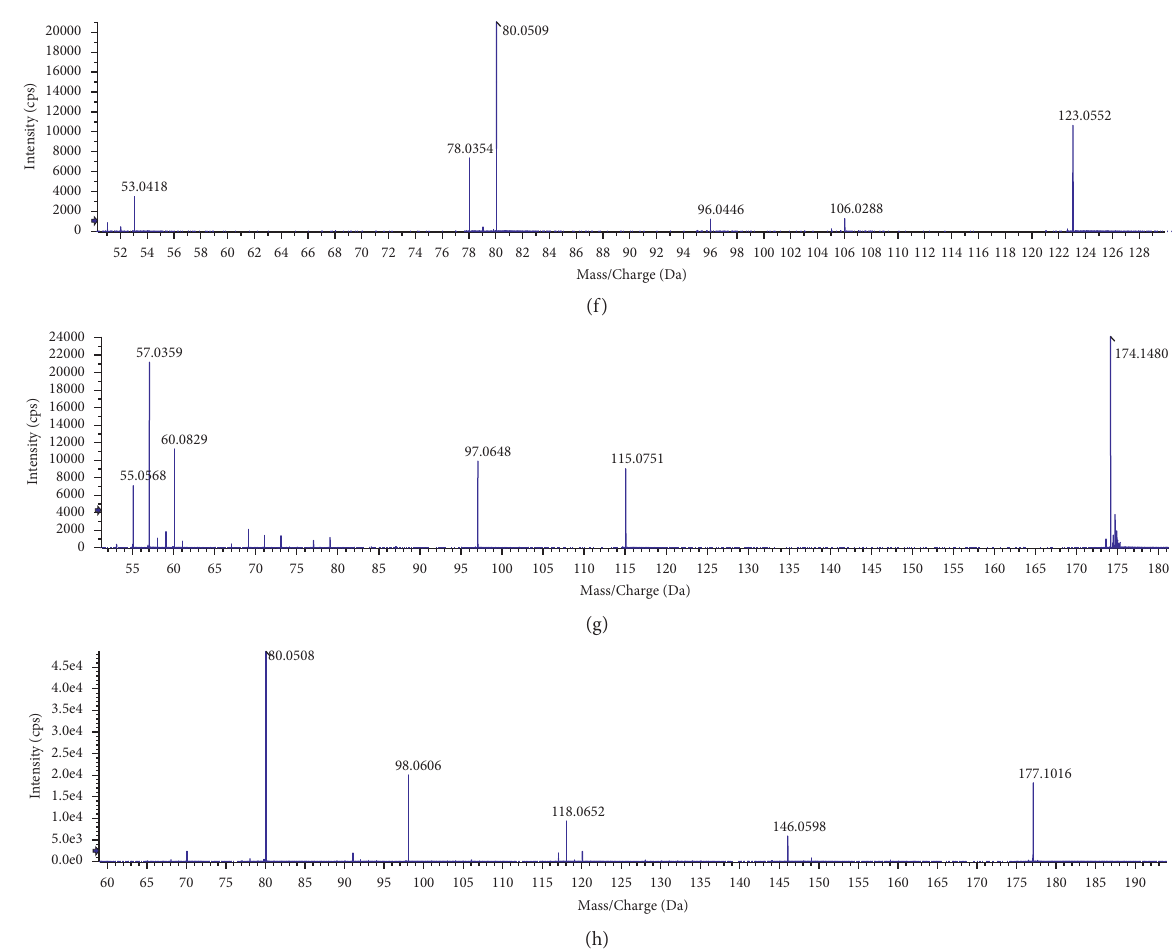
Figure 4: MS/MS spectra of the 8 endogenous alkaloids. (a) Nicotine. (b) Anabasine. (c) Choline. (d) Tryptamine. (e) Putrescine. (f) Nicotinamide. (g) Muscarine. (h)